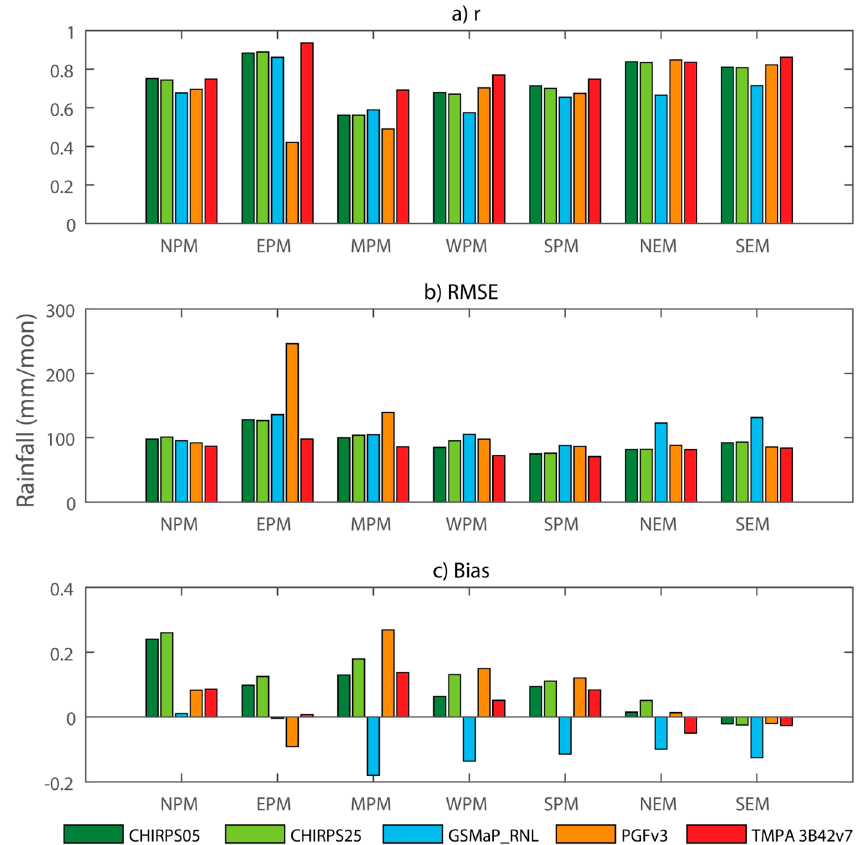
Figure 5. Monthly categorical performance scores of CHIRPS05, CHIRPS25, GSMaP_RNL, PGFv3 and TMPA 3B42v7 based on daily data: ( a ) POD, ( b ) FAR, ( c ) CSI.